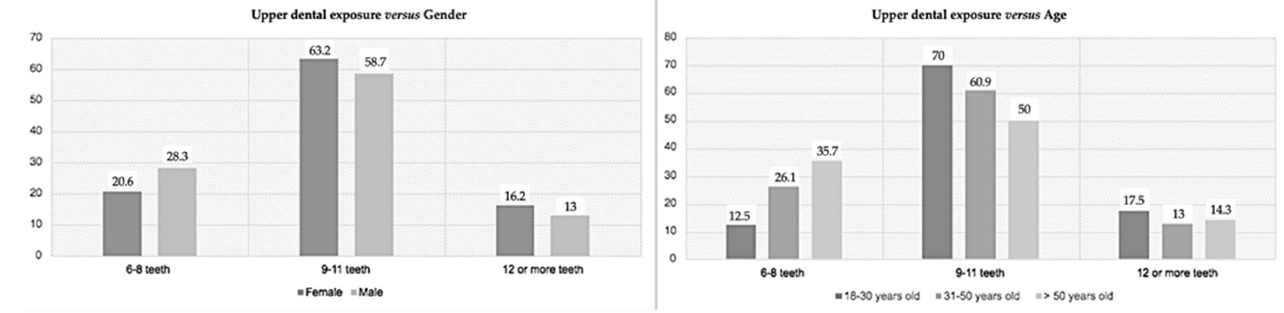
Figure 4. Prevalence of the smile arch according to gender ( left ) and age ( right ).